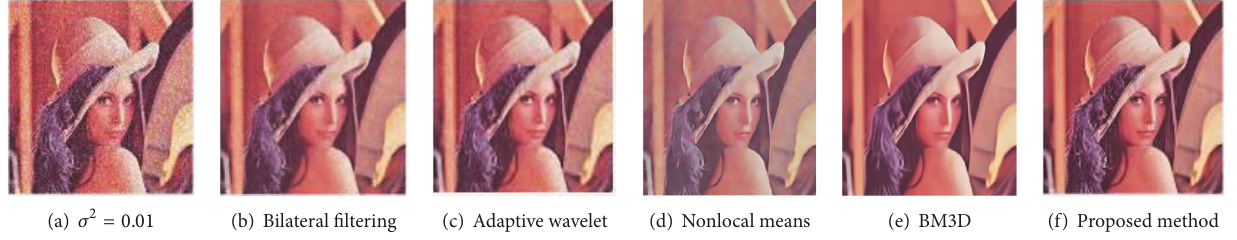
Figure 5: Image 1: comparison of various experimental results under noise variance 𝜎 2 = 0.01